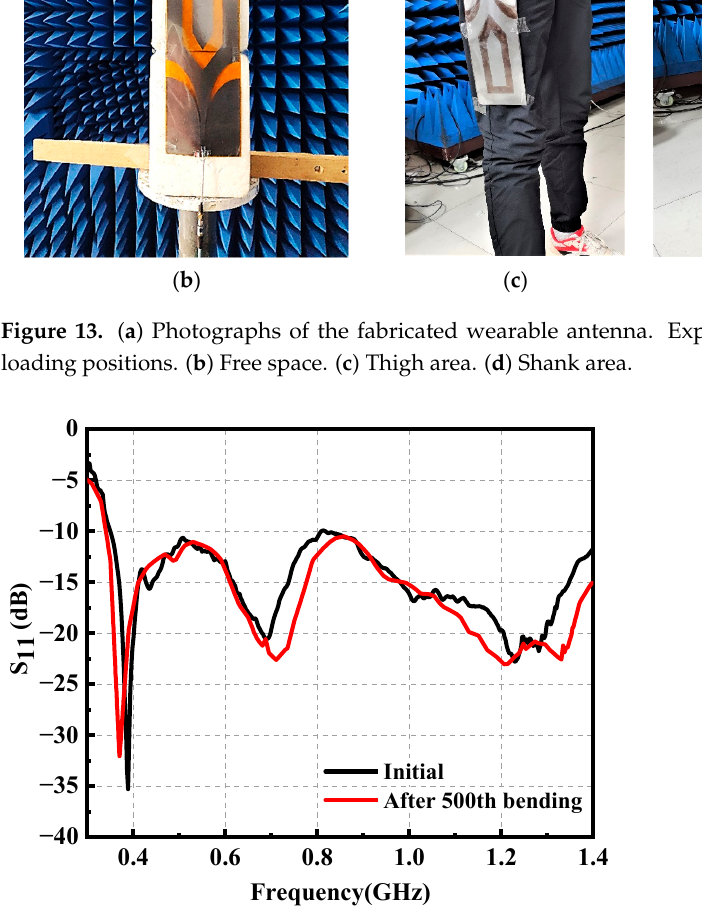
Figure 14. The reflection coefficient of the proposed antenna before and after bending.